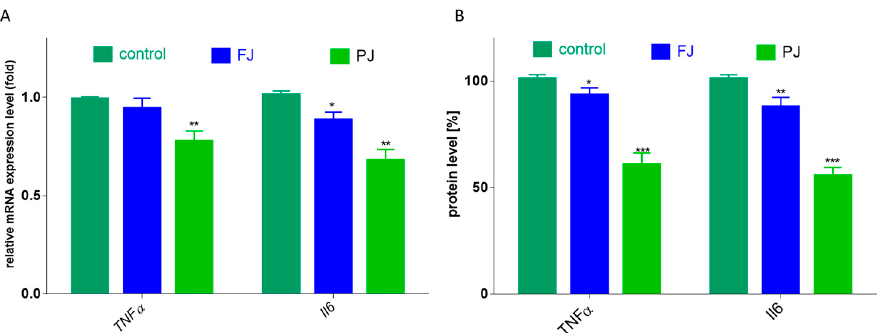
Figure 9. The influence V. opulus FJ and PJ at IC 0 on mRNA expression, quantified with real-time PCR and normalized using glyceraldehyde-3-phosphate dehydrogenase ( GAPDH ) as a reference gene ( A ) and protein secretion quantified with ELISA ( B ) of TNF α and Il6 in Saos-2 cells after 8 days of exposure; control cells were not exposed to any compound; values are means ± SEM, n = 4; statistical significance was calculated versus control cells * p ≤ 0.05, ** p ≤ 0.01, *** p ≤ 0.001.